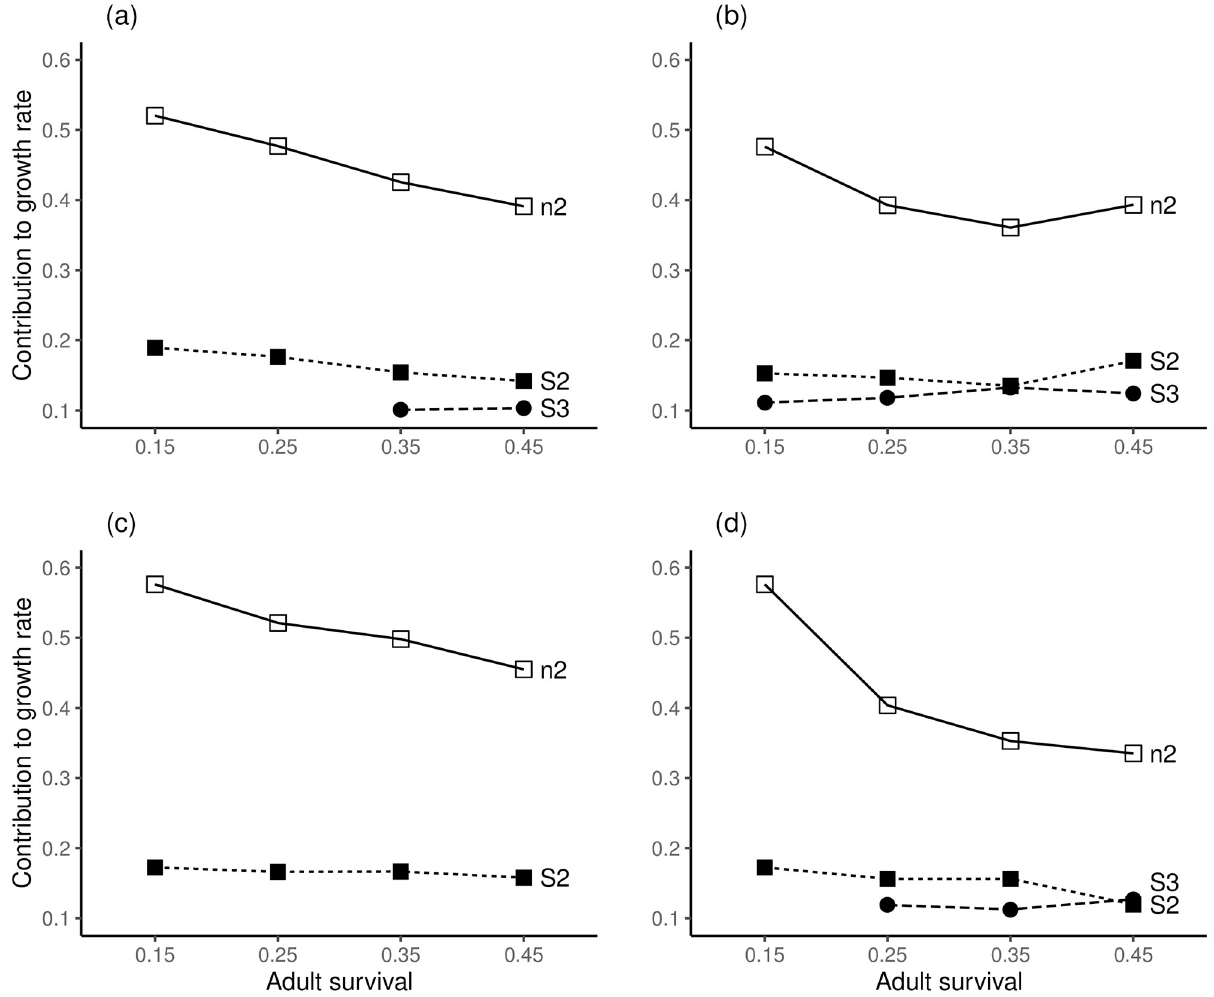
Fig 3. Simulations of age truncation for species with age 2 maturity. (a) a hypothetical species "average fish", (b) H . argyritis , (c) P . burchelli , (d) I . are shown: n 2 is number of age 2 fish, S 2 , and S 3 are survival probabilities for ages 2 and 3, lusitanicum ; proportional contributions exceeding 0.1 of s 2 l t respectively. A bar plot showing the contribution from each model parameter for each transient LTRE is provided in (S7–S10 Figs) for each species.